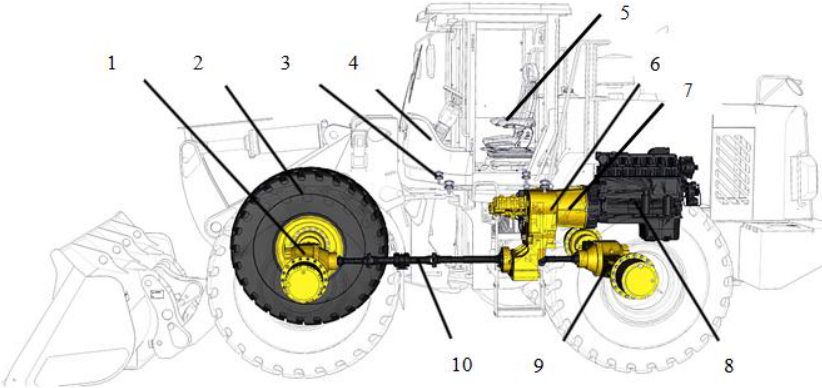
Figure 1. The power transmission path: 1. Front axle; 2. Tire; 3. Cab damper; 4. Cab; 5. Cab seat; 6. Transmission assembly; 7. Hydraulic torque converter; 8. Engine; 9. Rear axle; 10. Transmission shaft.